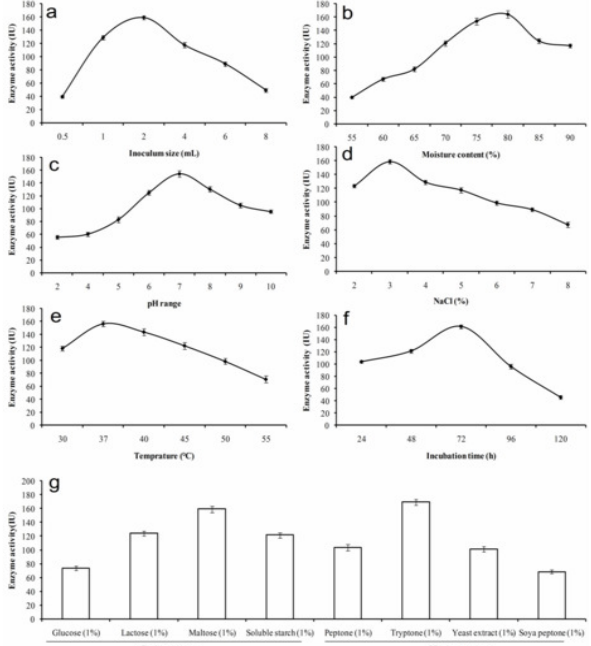
Fig. 1 . Optimization of α -amylase production by Bacillus amyloliquefaciens MCCB0075 in solid state fermentation through mix substrate of wheat and barley bran using one variable at a time approach. The variables are inoculums size ( a ), moisture content ( b ), pH ( c ), NaCl ( d ), temperature ( e ), incubation time ( f ) and, carbon and nitrogen source ( g ).